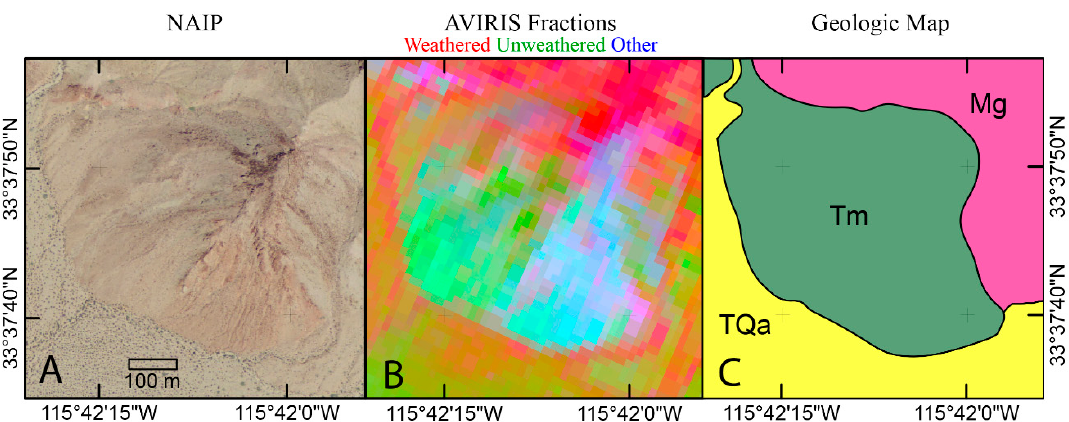
Figure 3. Characterization of the Maniobra study site. A. NAIP Imagery. B. Spectral unmixing result. Red = weathered endmember, Green = unweathered endmember, Blue = other materials. C. Geologic map after [34]. TQa = Tertiary-Quaternary alluvium. Tm= Tertiary Maniobra Formation. Mg = Mesozoic granitoids. Differentiation of weathered and unweathered materials is ambiguous at best using NAIP imagery alone (A) and is not represented in extant geologic map (C), but is visually evident and easily quantifiable by linear spectral unmixing of hyperspectral AVIRIS observations (B).